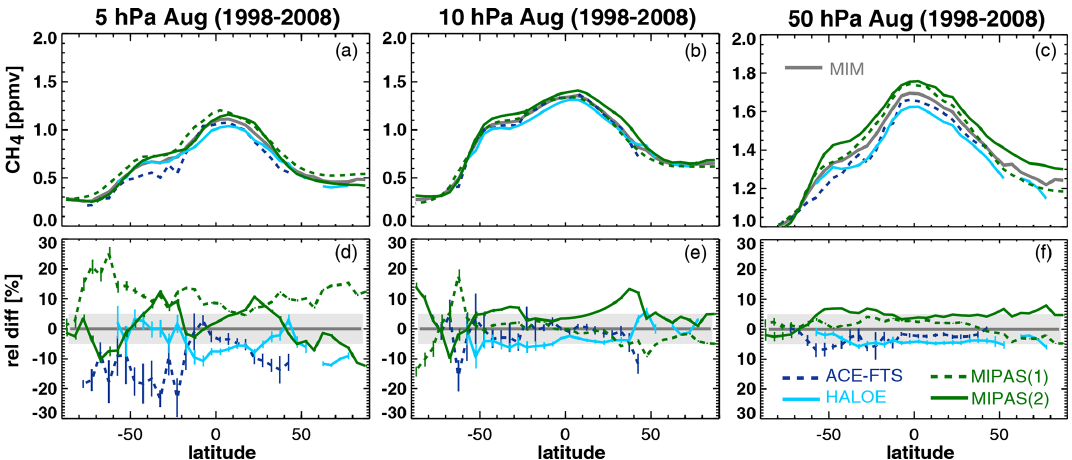
Figure 8. Meridional profiles of zonal monthly mean CH 4 at 5, 10, and 50hPa and averaged over 1998–2008 are shown for the different instruments and the MIM (a, b, c) . Differences between the individual instruments and the MIM are shown in the lower panels (d, e, f) . The grey shading indicates where the relative differences are smaller than ± 5% (thus where the datasets show very good to excellent agreement). Error bars indicate the uncertainty in the relative differences based on the SEM of each instrument.